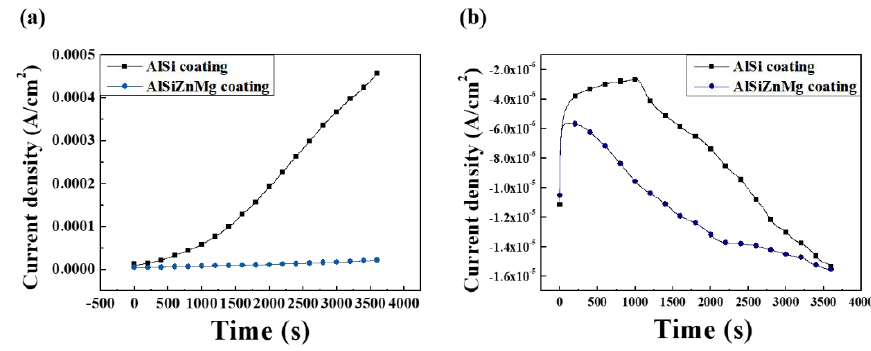
Figure 6. Potentiostatic polarization curves of AlSi-MC and AlSiZnMg-MC, measured after 1 h immersion in a 3.5% NaCl solution under ( a ) anodic (50 mV above OCP), and ( b ) cathodic (100 mV below OCP) potentials [20].